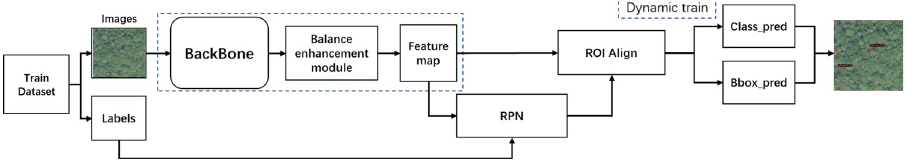
Fig 5. The overall flow chart of our proposed